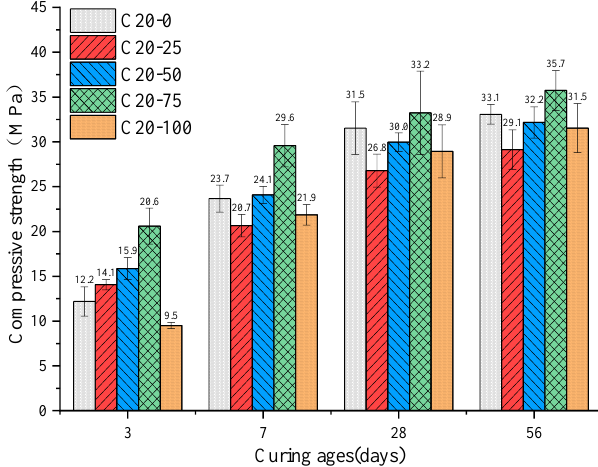
Figure 5. Compressive strength of C20 concrete. Overall, the influence of wastewater replacement rate on the cube compressive strength of C20 concrete has a different effect with the increasing age. With increasing the proportion of wastewater as a replacement for potable water, the cube compressive strength of concrete first increased and then decreased at the 3-day curing age. When the curing ages were 7, 28, and 56 days, the compressive strength of concrete first decreased, then increased, and then decreased.In addition, after 3 days, the compressive strength of concrete cubes of C20-25, C20-50, and C20-75 increased by 15.5% (1.9 MPa), 30.3% (3.7 MPa), and 68.9% (8.4 MPa), respectively, compared with C20-0. Nevertheless, the com- pressive strength of C20-100 concrete decreased by 22.1% (2.7 MPa). Therefore, the addi- tion of wastewater can improve the 3-day concrete strength, which may be attributed to the filler and nucleation effect accelerating the cement hydration, resulting in a denser structure [26]. However, too much wastewater may reduce the strength of C20-100. The reason may be that adding a superplasticizer prolongs the setting time and slows down the early strength growth [25,27]. The changing trend of concrete compressive strength was similar for 7, 28, and 56- day ages. Considering the 28-day age as an example, with the increase in the wastewater potable water content, the concrete compressive strength for C20-25, C20-50, and C20-100 decreased by 14.9% (4.7 MPa), 4.8% (1.5 MPa), and 8.3% (2.6 MPa), respectively, compared with C20-0. However, the strength of C20-75 increased by 5.4% (1.7 MPa). It may be at- tributed to the absorption of hydration water by the wastewater particles, reducing the saturated pores for hydrate growth and precipitation. Additionally, the saturated pores filled with water are smaller than the critical pores for hydrate growth and precipitation, leading to decreased strength [28]. To sum up, increasing the proportion of wastewater as a replacement for potable water will have different effects on the cube compressive strength of C20 concrete at dif- ferent ages. When the proportion of wastewater replacing potable water is 75%, the com- pressive strength of C20 concrete is the highest. Appropriate wastewater instead of pota- ble water can enhance the compressive strength of C20 concrete. 3.3. XRD The XRD test results of concrete specimens at the ages of 7 and 28 days are shown in Figure 6. The main products in concrete are SiO 2 , Ca(OH) 2 , CaCO 3 , and Aft. Wastewater